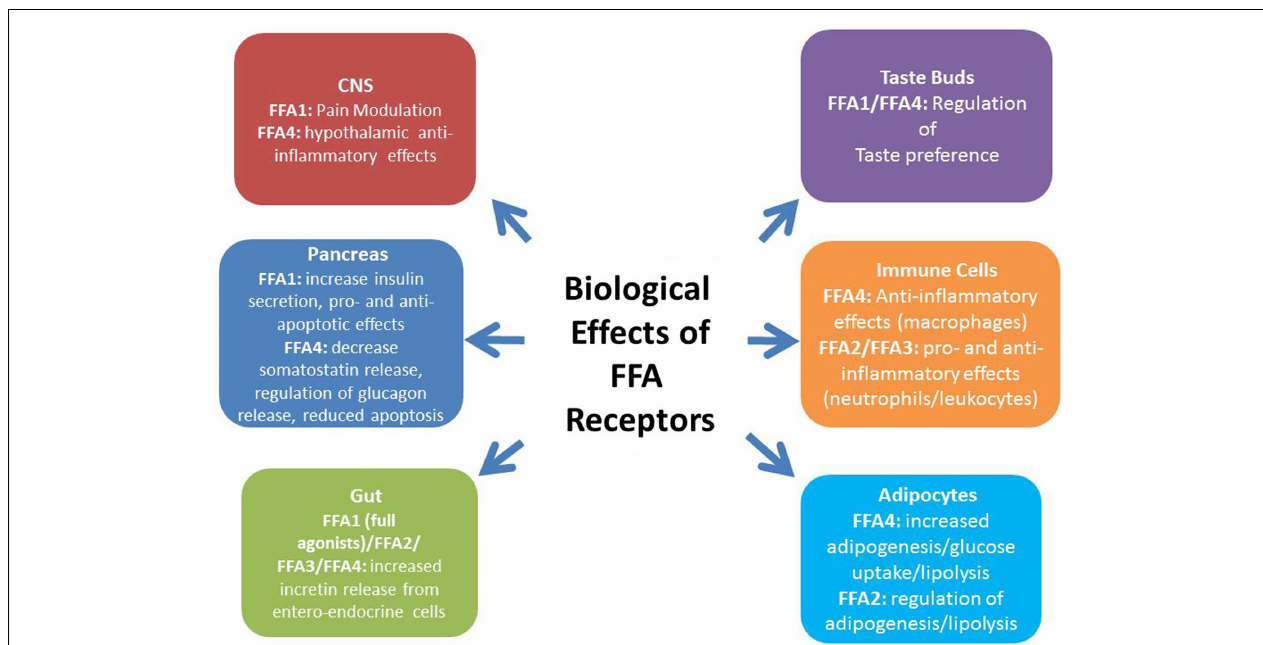
gut, as well as an anti-inflammatory effect on macrophages that, in turn, may improve systemic insulin sensitivity. In the pancreas, FFA4 is associated with reduced cell apoptosis and FFA4 has recently been detected in alpha and delta cells and regulates glucagon and somatostatin release, respectively. Both FFA1 and FFA4 have been detected in taste buds although the full implications of this in relation to obesity remain to be determined.The SCFA receptors, FFA2/FFA3, have recently been linked with the beneficial metabolic effects associated probiotics within the gut. Both receptors have been linked with incretin release from enteroendocrine cells, as well as both systemic anti- and pro-inflammatory effects. However, due to conflicting results using receptor-specific knockout models and a limited selection of pharmacological tools, more work is required to elucidate the physiological effects of FFA2 and FFA3